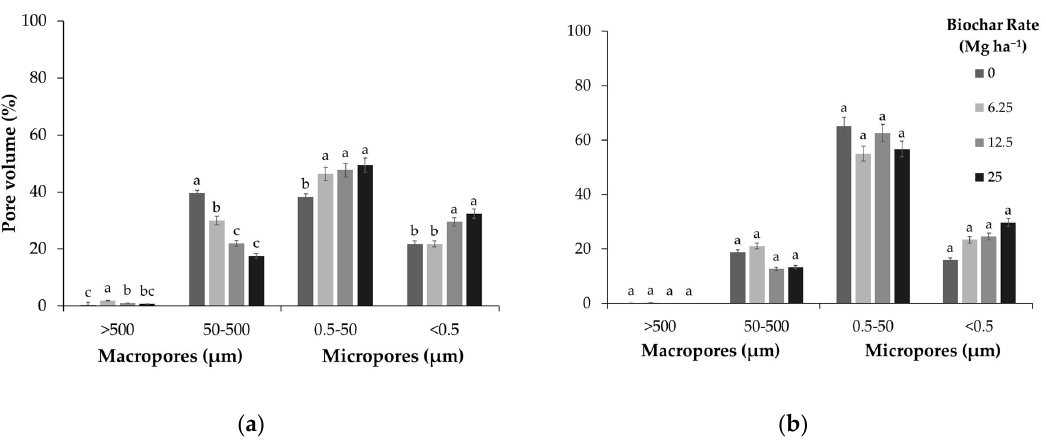
Figure 4. Soil pores size distribution as a function biochar rates (0, 6.25, 12.5, and 25 Mg ha − 1 ) evaluated at ( a ) 50 days and ( b ) 150 days after incorporation in soil. n = 4. Different letters on the bars indicate significant differences among treatments according to Tukey’s test ( p < 0.05).